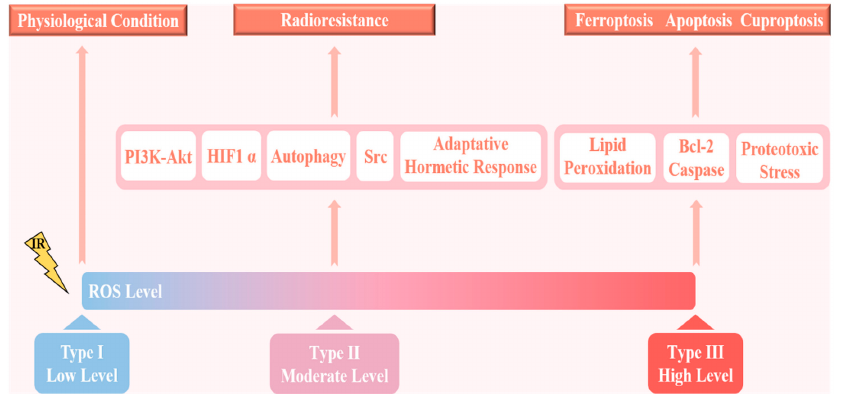
Figure 2. A schematic diagram of the different physiological effects of varying ROS concentrations. Under physiological conditions, ROS levels are maintained at a low state under the regulation of antioxidant systems, which ensures the survival of normal cells. Moderate levels of ROS tend to promote tumor initiation and progression, and to some extent interfere with the efficacy of radiotherapy. A continued rise in ROS levels to high levels will lead to cell death.